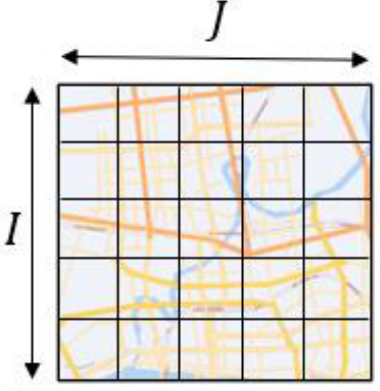
Figure 4. Map divided into an 𝐼 × 𝐽 grid.